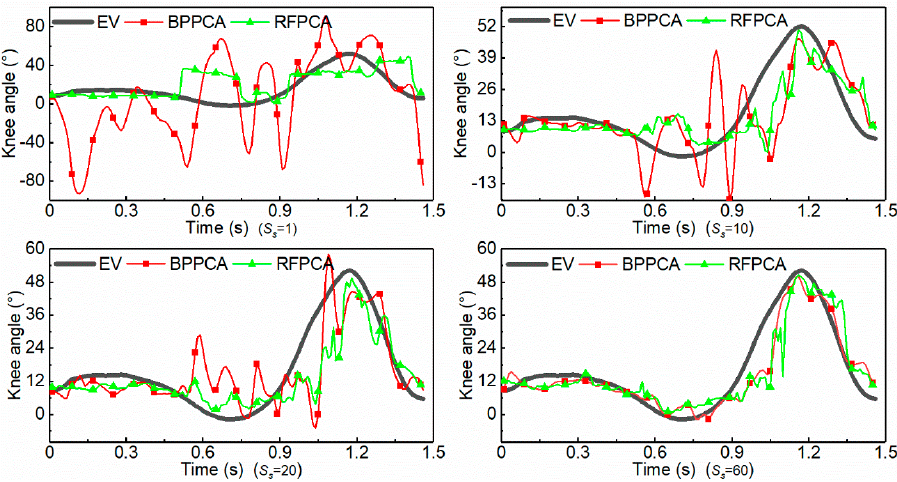
Figure 6. Partial results for estimation with different sample sizes of Subject 1.